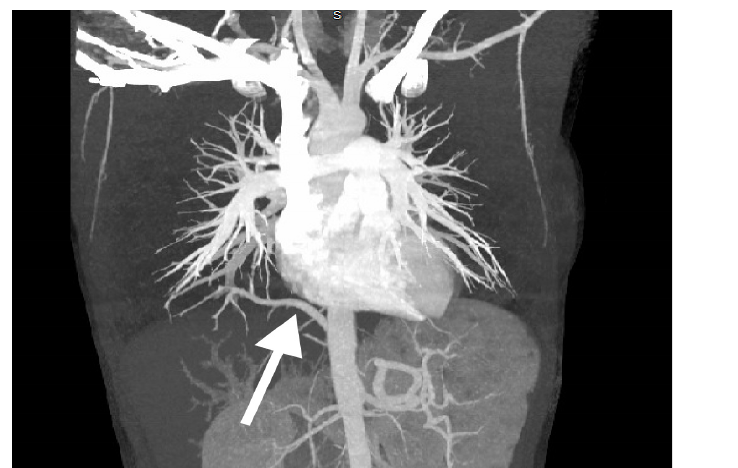
Image 1. Computed tomography angiogram demonstrating the right lower lobe pulmonary artery arising from the descending aorta beyond the level of the diaphragm (arrow).